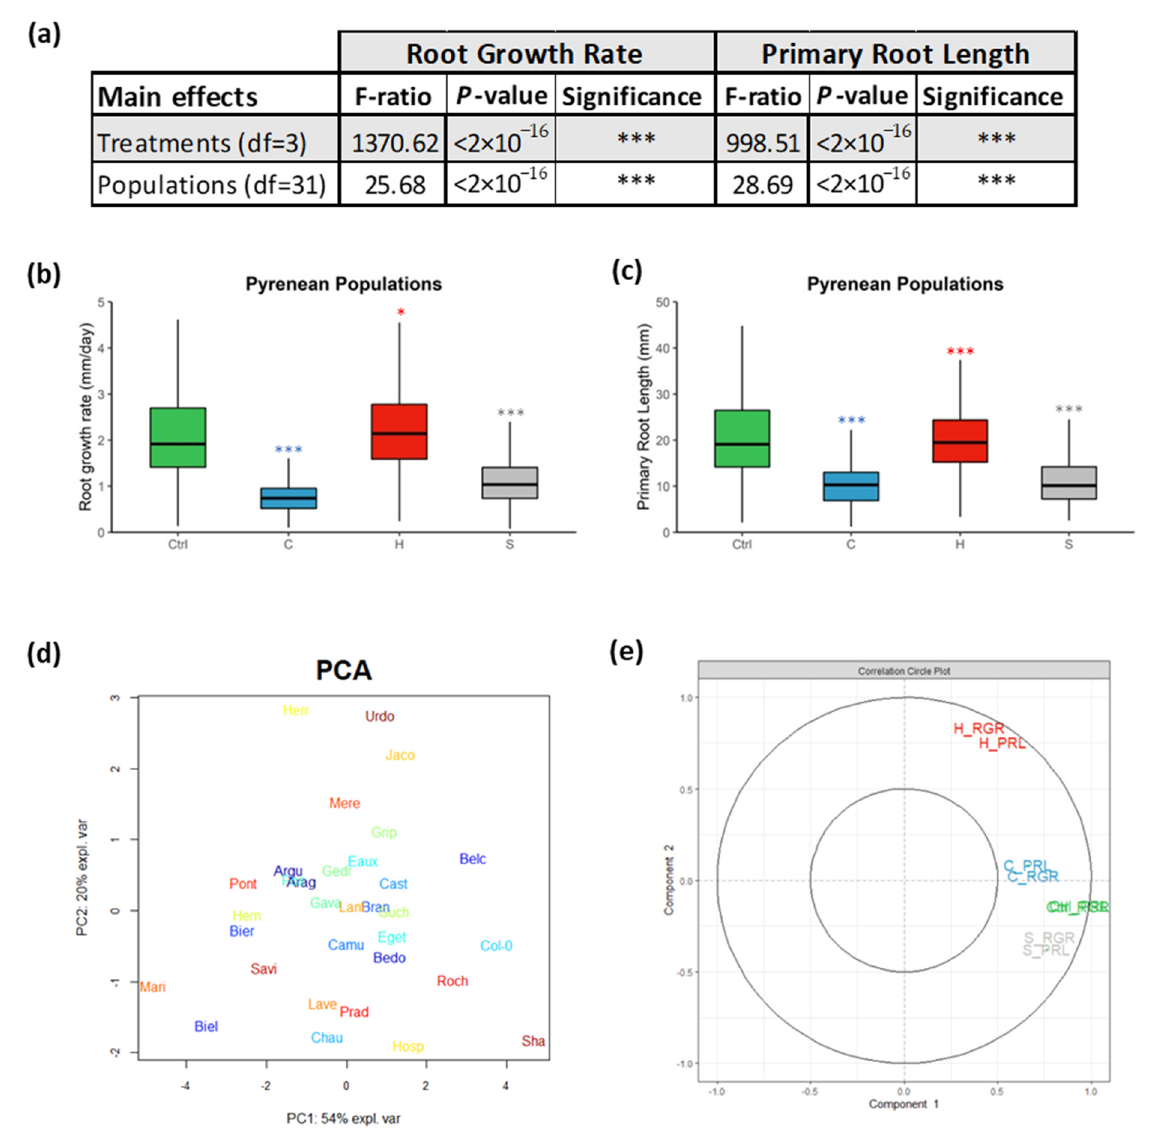
Figure 1. ( a ) Two-way ANOVA showing the main effects of the “Treatments” and the “Populations” on the two measured root parameters: “Root Growth Rate” and “Primary Root Length”. Boxplots displaying ( b ) the root growth rates (mm/day) and ( c ) the primary root lengths (mm) of the A. thaliana Pyrenean populations. PCA score plot ( d ) displaying the studied populations spanning the principal components PC1 (54%) and PC2 (20%) that summarize the measured primary root lengths (PRLs) and root growth rates (RGRs) under the four treatments. Correlation circle ( e ) representing the contribution of the measured variables to the principal components (PC1 and PC2). (***) signified the p -value < 0.0001 of the Student’s t -test of the pairwise comparisons between each treatment and the ctrl on the PRL and RGR of each population. * p -value < 0.01.